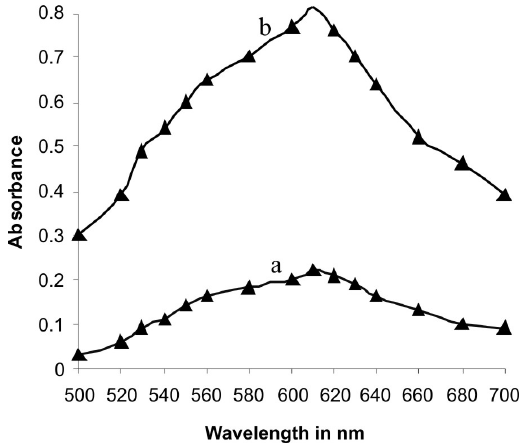
FIGURE 4 - Absorption spectra for method B (a. reagent blank; b. coloured species produced for 8 µg mL -1